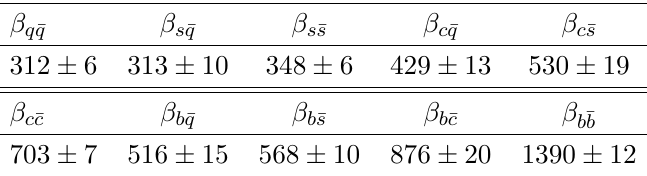
Table 2 . The values of Gaussian parameters (cid:12) (in units of